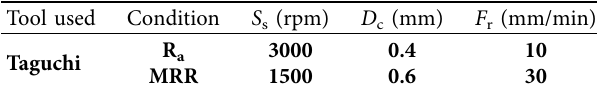
Table 10: Optimized parameter for both dry run and MQL. Tool